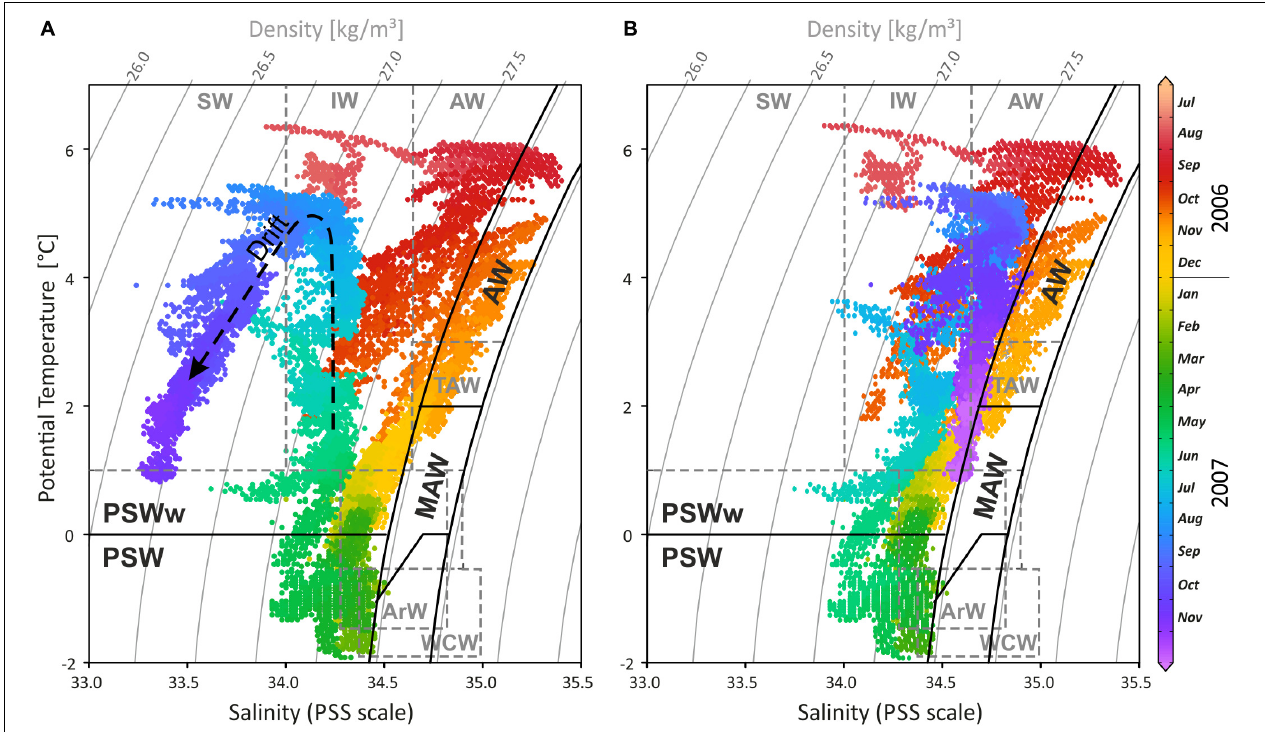
FIGURE 4 | (A) Temperature-salinity-density diagram of the CT logger on the settlement platform, highlighting the temporal variability of water masses during the 15-month record in 2006/2007 (colours correspond to recording time). Waters were cooling and freshening from 6 ◦ C in August 2006 down to nearly the freezing point in April 2007 following the mixing line between the external water masses, the Atlantic Water (AW) and the Arctic Water (ArW), forming first Modified or Transformed Atlantic Water (MAW or TAW) and later Polar Surface Water (PSW). During spring and summer 2007 temperatures were increasing while salinity remained low, occupying the TSD field of warm Polar Surface Water (PSWw). As temperatures rised to summer values, salinity decreased further, indicating the drift artefact (dashed arrow). (B) Drift corrected salinity data with –0.2 on the PSS scale per month starting from mid May 2007. Water mass characteristics in black follow Rudels et al. (2000) and in dashed grey Cottier et al. (2005). SW, Surface Water; IW, Intermediate Water; TAW, Transformed Atlantic Water ( ∼= MAW); WCW, Winter Cooled